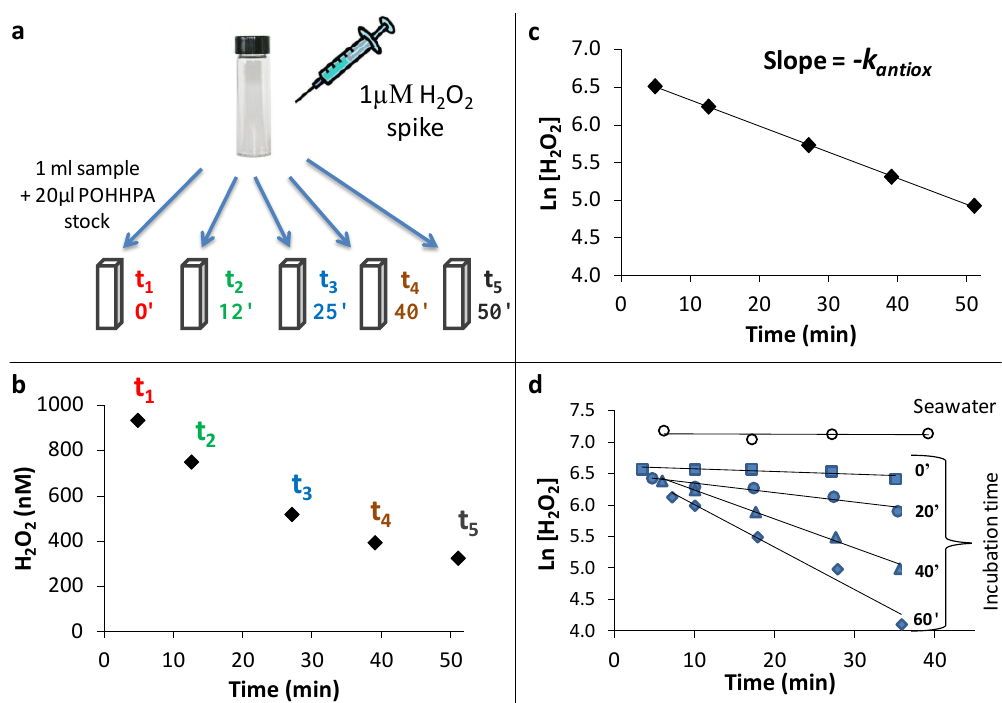
Figure 1. Determination of antioxidant activity in coral incubation water. (a) H 2 O 2 spike is added to a sample, mixed, and subsampled into cuvettes containing PHOPPA reagent at time intervals ranging from a few minutes to a few hours. (b) H 2 O 2 concentrations decline with time due to the antioxidant activity. The exponential decline is typical of pseudo-first-order kinetics. (c) The antioxidant activity of a sample is evaluated from the decay constant ( k antiox ) obtained by plotting the natural log of the H 2 O 2 concentration versus time. (d) The antioxidant activity released from the coral accumulates with time in the incubation water. Subsequently, samples collected throughout the incubation show faster H 2 O 2 degradation rates and higher decay constants ( k antiox )